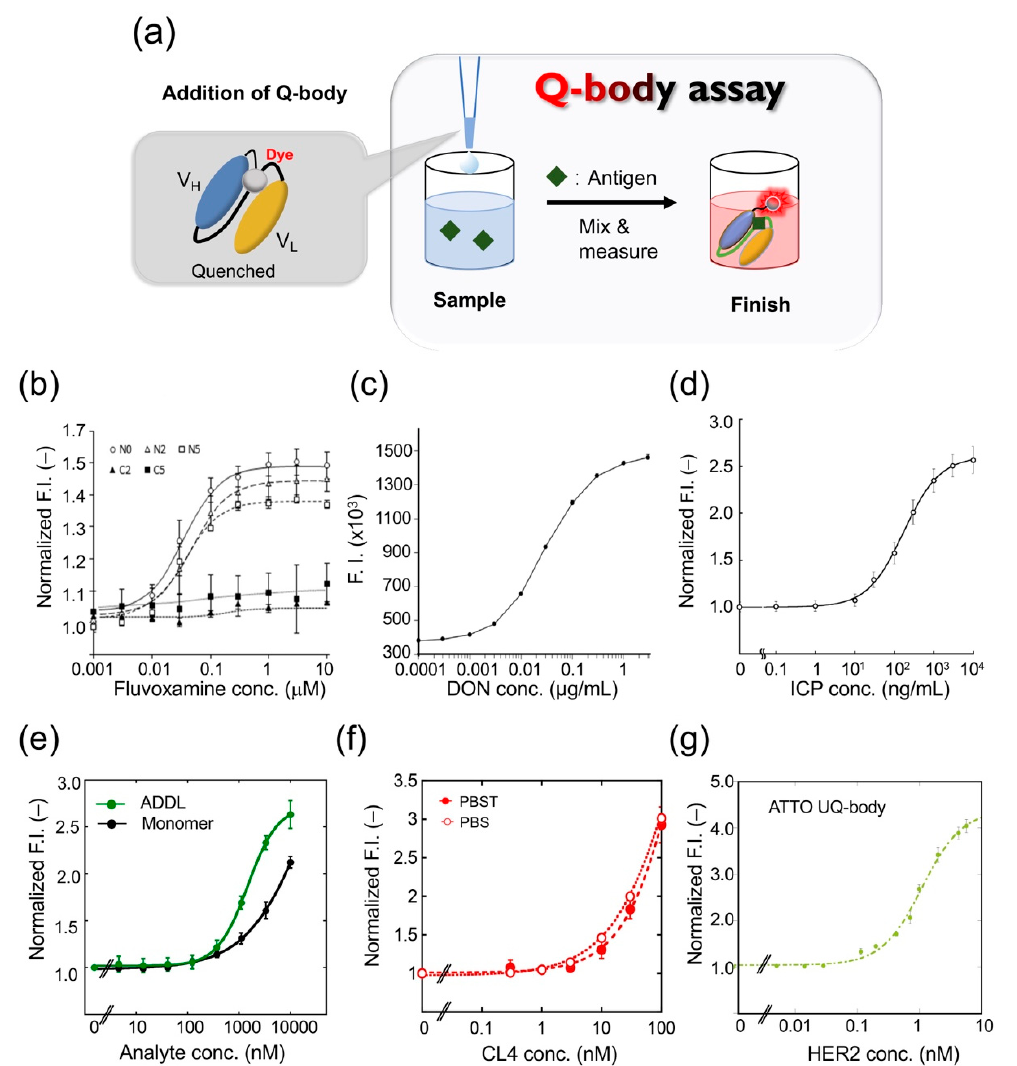
Figure 3. Quenchbody assays for analyte detection. ( a ) Schematic image for Quenchbody assay. ( b ) Detection of fluvoxamine. ( c ) Detection of deoxynivalenol (DON). ( d ) Detection of imidacloprid (ICP). ( e ) Detection of β -amyloid monomer and oligomer (ADDL)s. ( f ) Detection of claudin 4 (CL4) in PBS and PBS containing 0.05% Tween 20 (PBST). ( g ) Detection of human epidermal growth factor receptor 2 (HER2) extracellular domain.